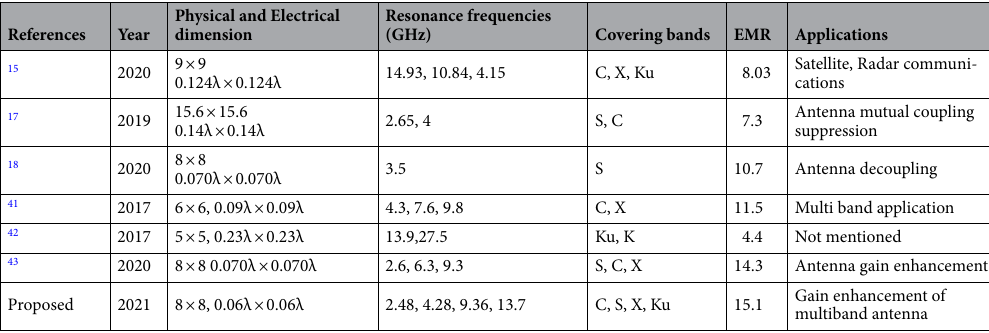
Table 5. Comparison of proposed MTM with recent works in terms of dimension, resonances, covering bands, EMR, and